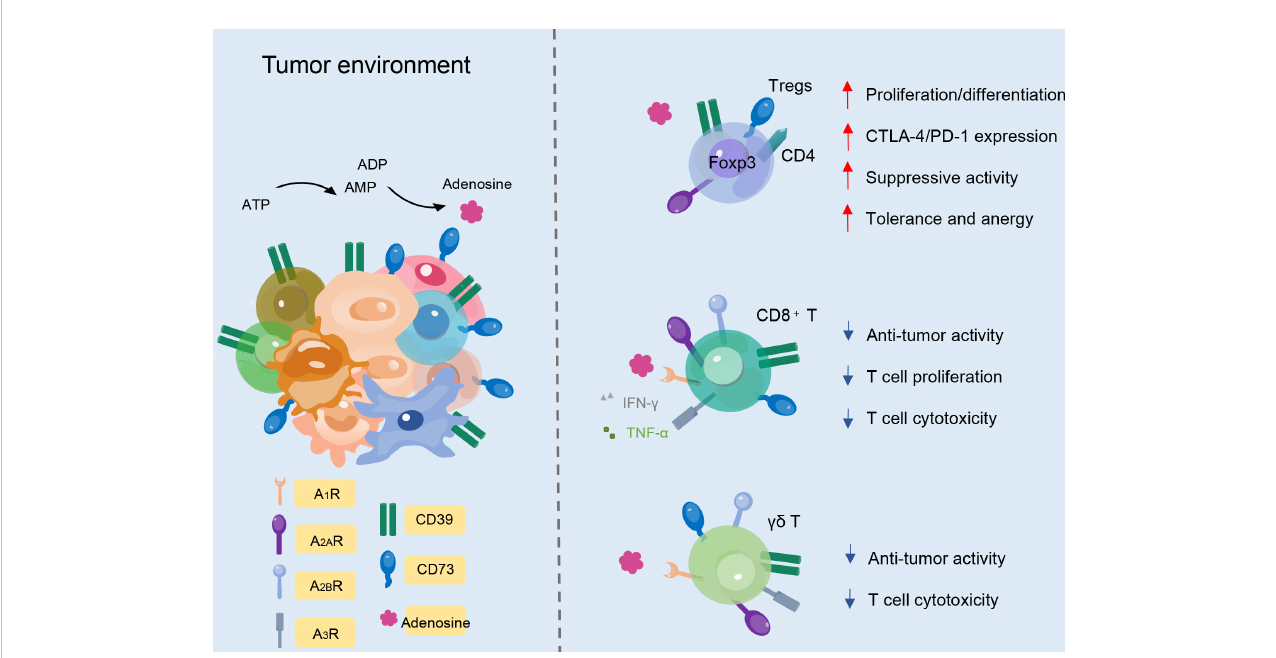
FIGURE 3 CD39 and CD73 expression on different T cell subtypes. In Foxp3 + CD4 + Treg cells, CD39 and CD73 improve immunosuppressive activity. In CD8 + T cells, ectonucleotidases decrease cytotoxicity, proliferation, and anti-tumor activity. Likewise, CD39 and CD73 expression on gd T cells can also decrease anti-tumor activity and T cell